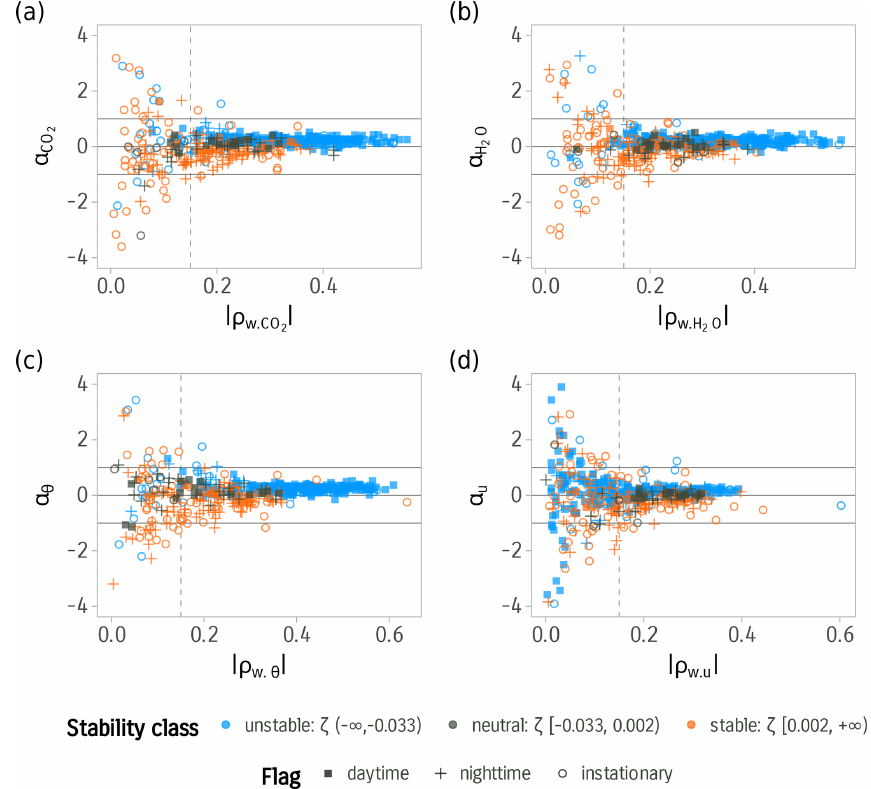
Figure 2. Observed values of the transport asymmetry coefficient α vs. the correlation coefficient for four variables calculated from high- frequency measurements. (a) CO 2 , (b) H 2 O, (c) sonic temperature, θ , and (d) wind velocity component, u . Colors distinguish different stability classes. The point shape differentiates daytime, nighttime, and instationary conditions following Foken and Wichura (1996). The vertical dashed line is set to x = 0 . 15, and the horizontal lines are set to y = − 1 and y =